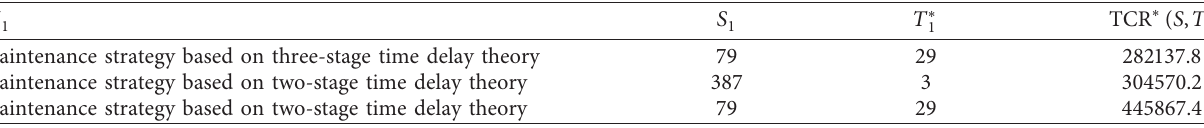
Figure 13: Diagram of the cost rate (in $/year) of machine M Table 11: Comparison of two maintenance